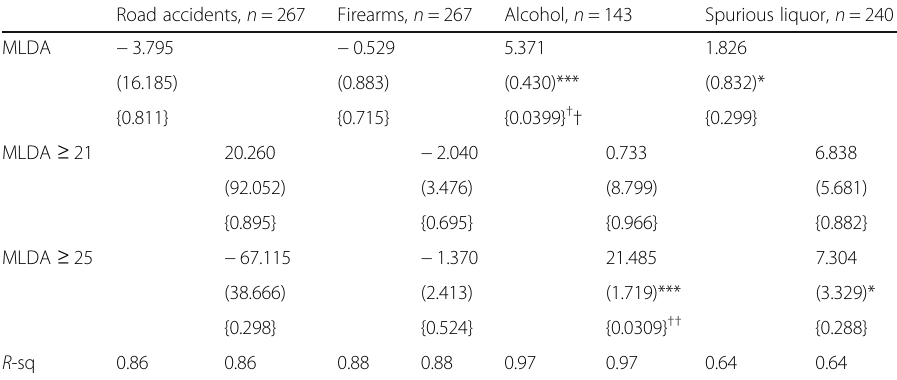
Table 11 The impact of alcohol regulation on mortality in states never under prohibition Road accidents, n =